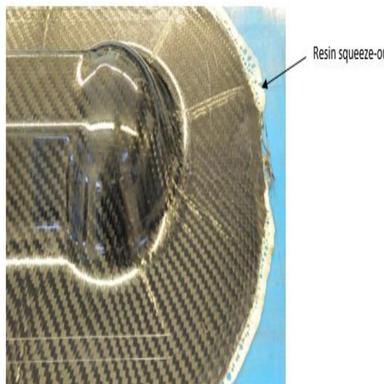
Resin squeeze out effect on a thermoset prepreg double-dome part.